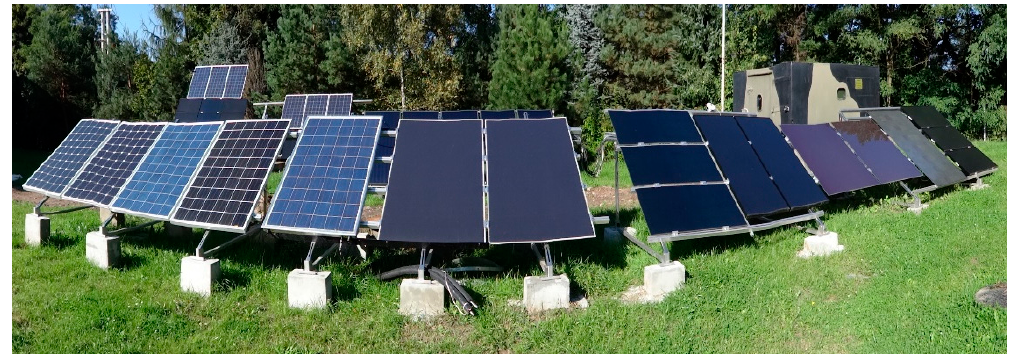
Figure 1. The installation with different photovoltaic (PV) modules.